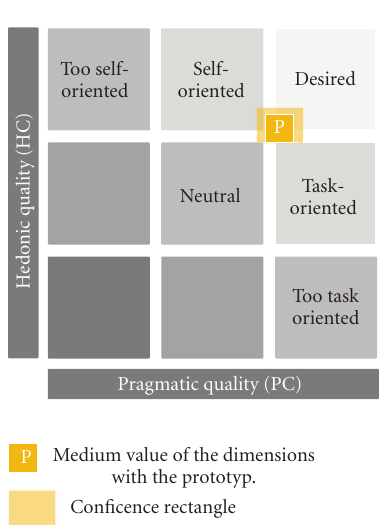
Figure 2: Results Attrakdi ff -Portfolio Representation.